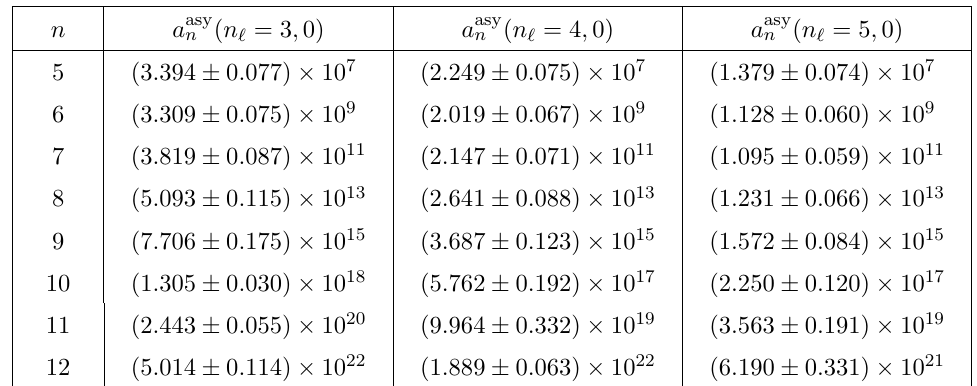
= 3 ; 4 ; 5 using the values for the N ( n ‘ ) from ‘ 1 = 2